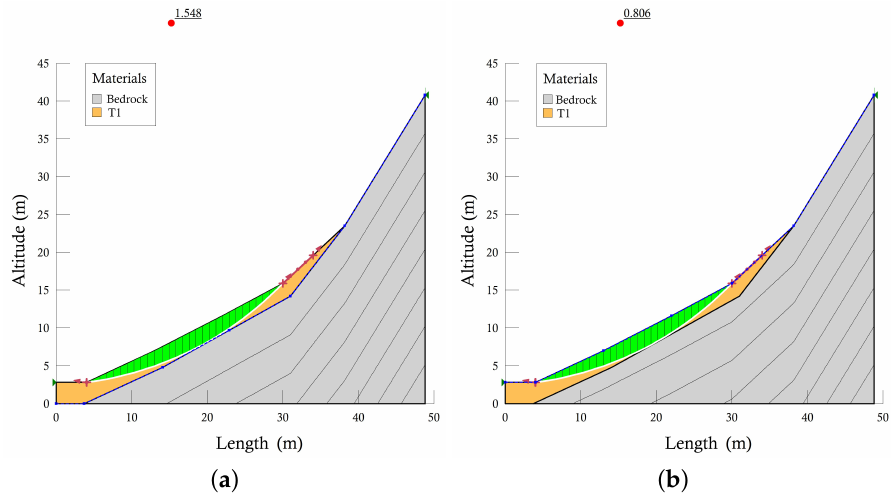
Figure 13. Deterministic analysis: Slope profile n.2: ( a ) no water and ( b ) piezometric line at the ground